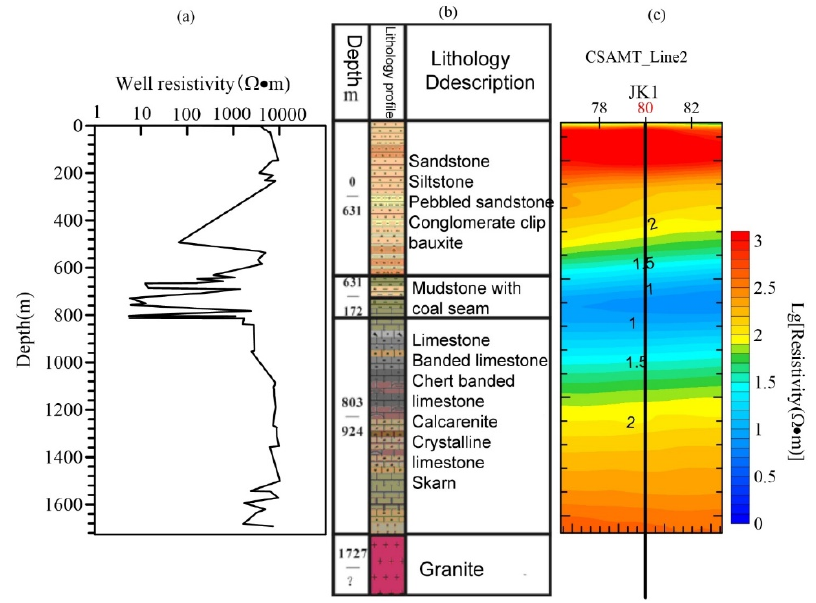
Figure 7. ( a ) The resistivity logging curve. ( b ) Drilling geological section. ( c ) CSAMT Line 2 inverted section. 80th is the drilling sites. Table 1. Stratigraphic interpretation with log data and core drilling.